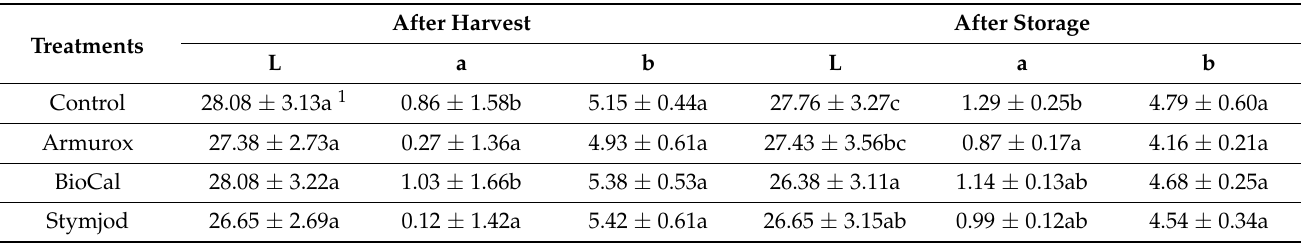
Table 7. Highbush blueberry fruit coloration in